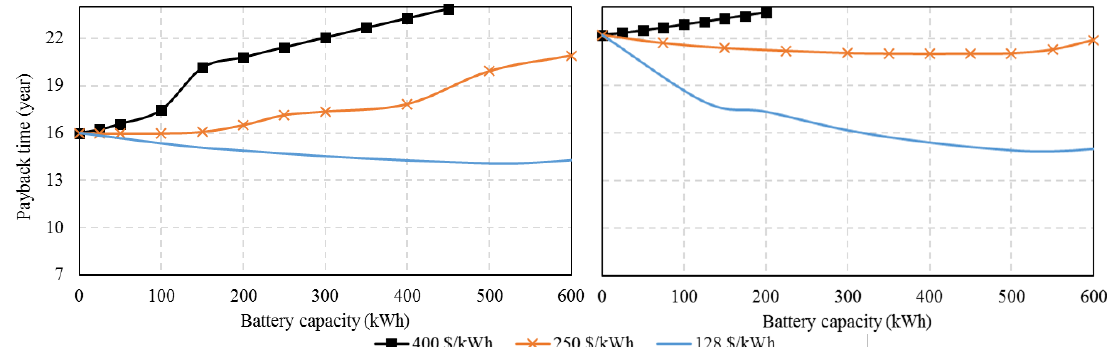
Figure 12. The effect of the battery capacity on the payback time of the PV system for feed-in tariff =6.7 ₵ /kWh ( left ), and 3.35 ₵ /kWh ( right ). Annual saving target 100%.